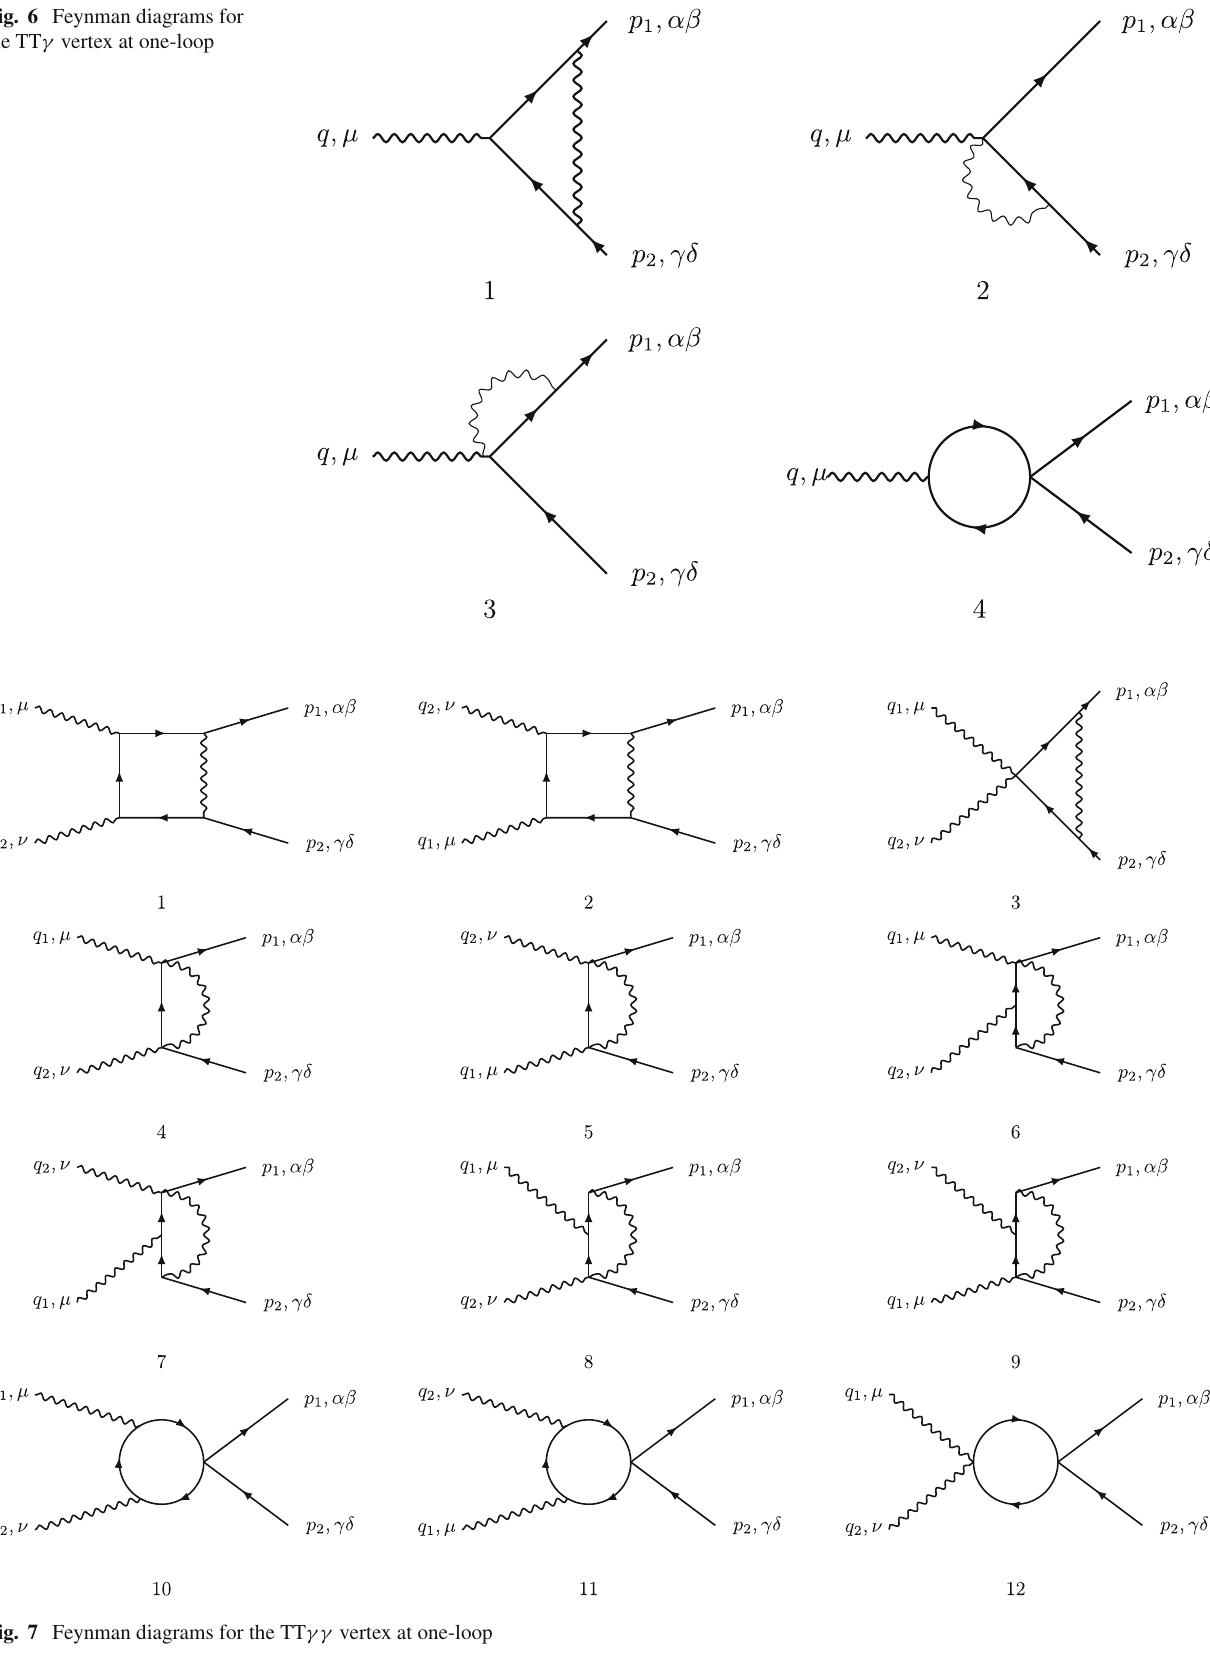
Fig. 6 Feynman diagrams for the TT γ vertex at one-loop